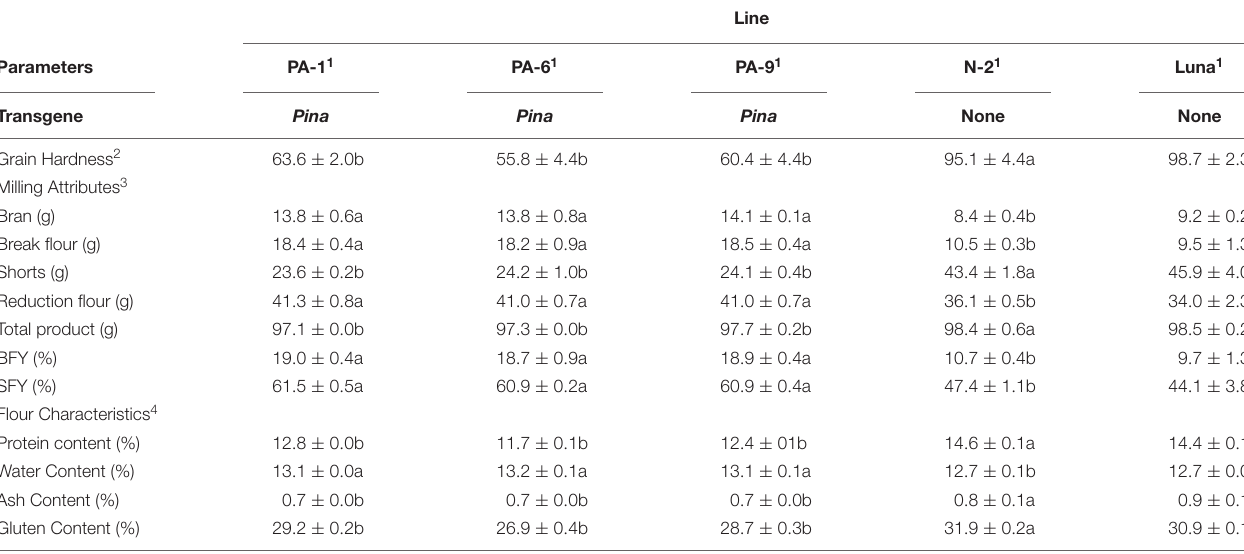
TABLE 1 | Grain hardness, milling attributes, flour characteristics, and color parameters of the transgenic and control lines.